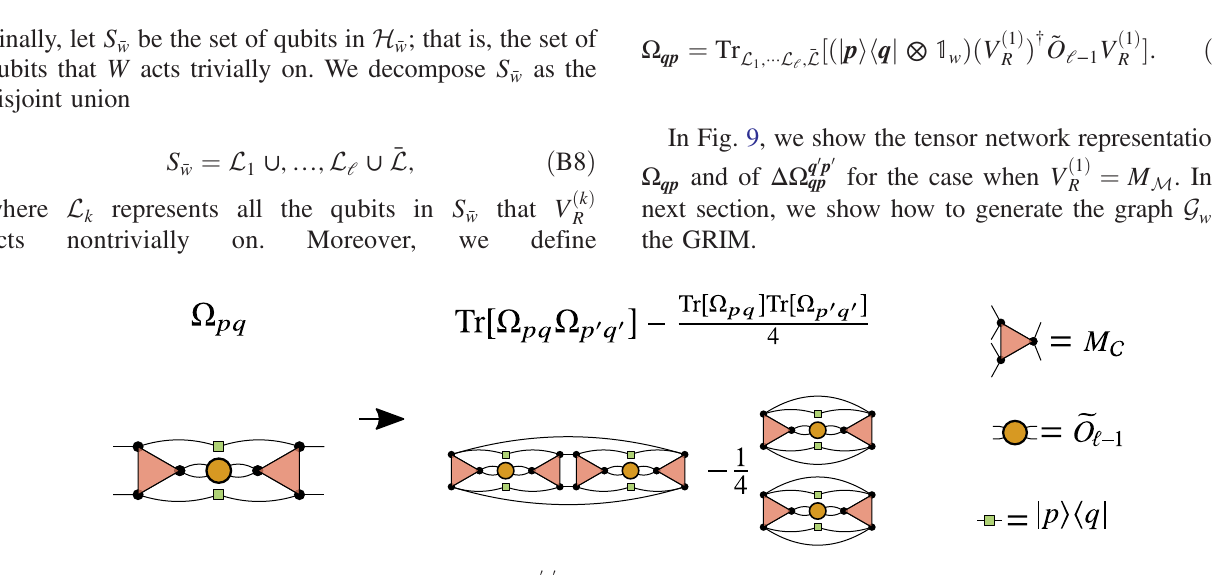
and ΔΩ q 0 p 0 qp . Here we consider the case where W is in the middle of the l th layer. qp